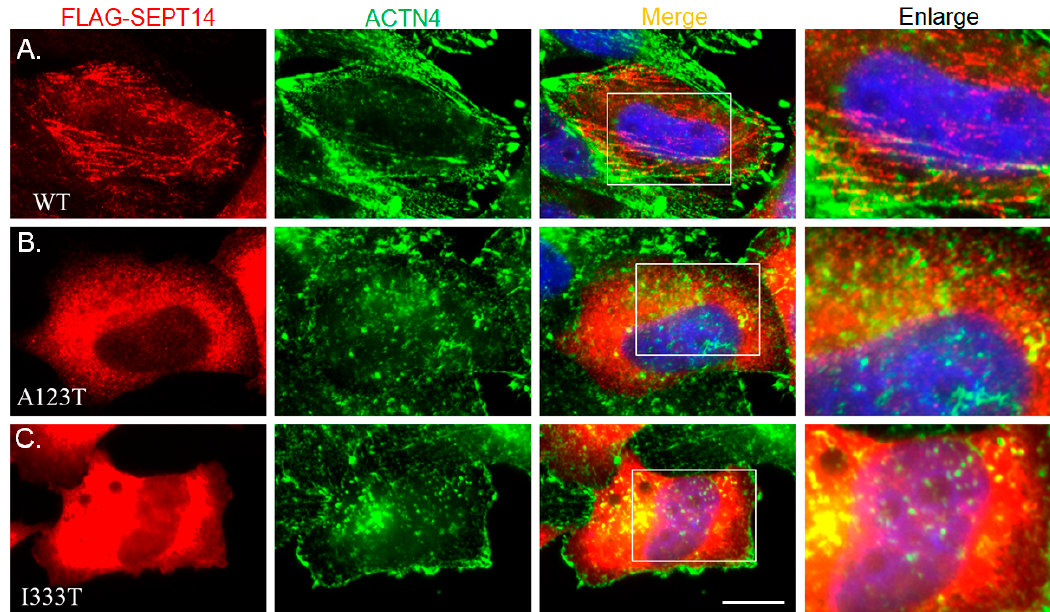
Figure 4. Mutated SEPT14 affects the filament structure of ACTN4. ( A – C ) Immunofluorescence staining of cells transfected with plasmids encoding WT FLAG-SEPT14 (WT panel), FLAG-SEPT14 A123T (A123T panel), and FLAG-SEPT14 I333T (I333T panel) with FLAG and ACTN4 antibodies. From left to right: Images of FLAG antibody (FLAG- SEPT14 ), ACTN4 antibody (ACTN4), and DAPI staining and merged images with FLAG antibody, ACTN4 antibody, and DAPI staining (Merge), as well as an enlarged image (Enlarge). Magnification, 1000×. Scale Bar: 10 μ M.